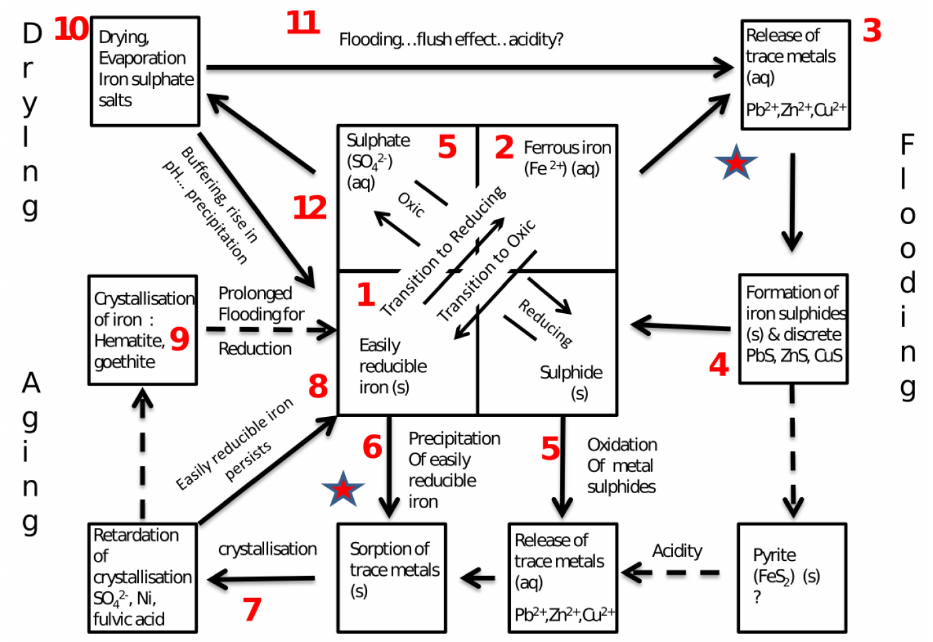
Figure 1. Simplified conceptual model to show changes in iron and sulphur species and effects on contaminant trace metal release in response to changes in redox potential and drying at different temporal scales. The red star indicates a process rate limited by the availability of easily reducible